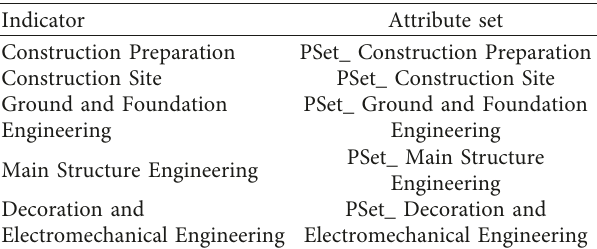
Figure 2: The process of IFC extension. Table 1: Indicator attribute set.